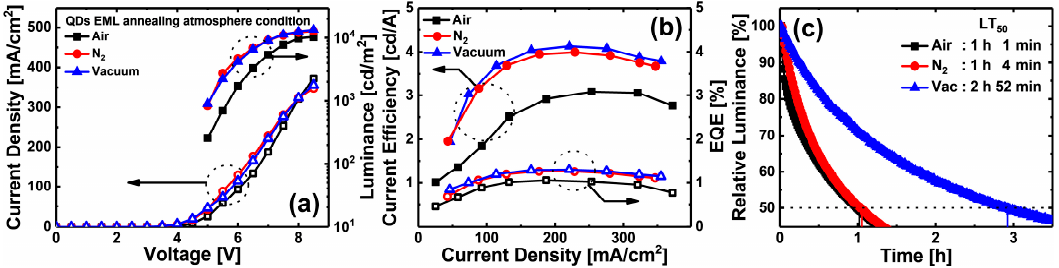
Figure 8. Comparison of ( a ) current density and luminance-voltage, ( b ) current efficiency and EQE-current density, and ( c ) LT 50 characteristics of the ink-jet printed QLEDs annealed under each annealing atmospheric condition.